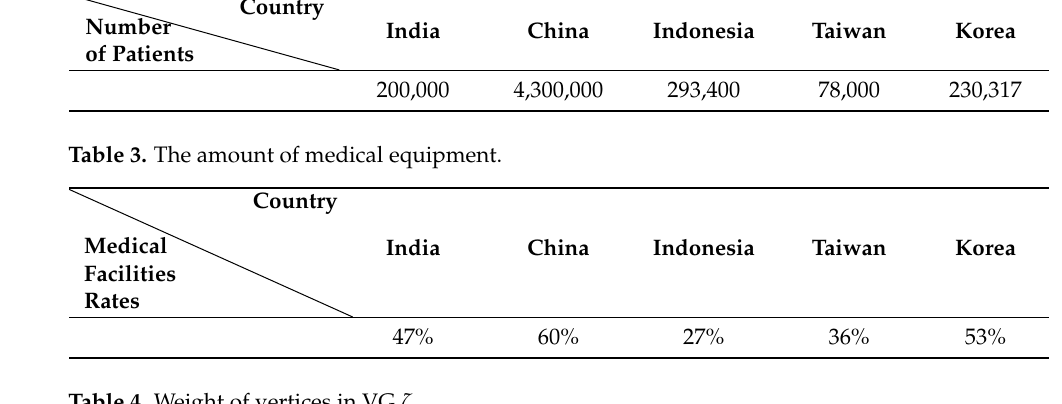
Table 4. Weight of vertices in VG ζ .